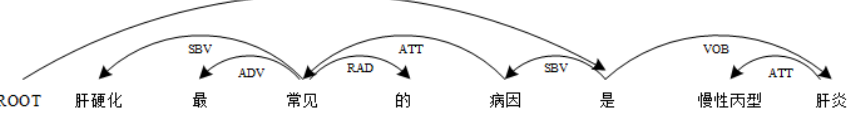
Figure 2. Dependency tree. The Chinese sentence in the figure means “The most common cause of liver cirrhosis is chronic hepatitis C”. “ 肝 硬 化 ” represents “liver cirrhosis”, “ 最 ” represents “the most”, “ 常 见 ” represents “common”, “ 的 ” represents “of”, “ 病 因 ” represents “cause”, “ 是 ” represents “is”, “ 慢 性 丙 型 ” represents “chronic C”, “ 肝 炎 ” represents “hepatitis”. Root, root node; SBV, subject– predicate relation; ADV, dative–medial relation; ATT, definitive–medial relation; RAD, right-additive relation; VOB, verb–object